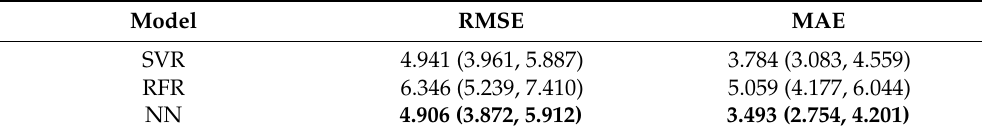
Table 4. Root mean squared error (RMSE) and mean absolute error (MAE) results for the performance comparison of data2vec embeddings using the held-out ADReSSo test data. The 95% confidence intervals are reported for both the RMSE and MAE of each model. Bold indicates the overall best score for the metric. SVR: support vector regressor; RFR: random forest regressor; NN: neural network.